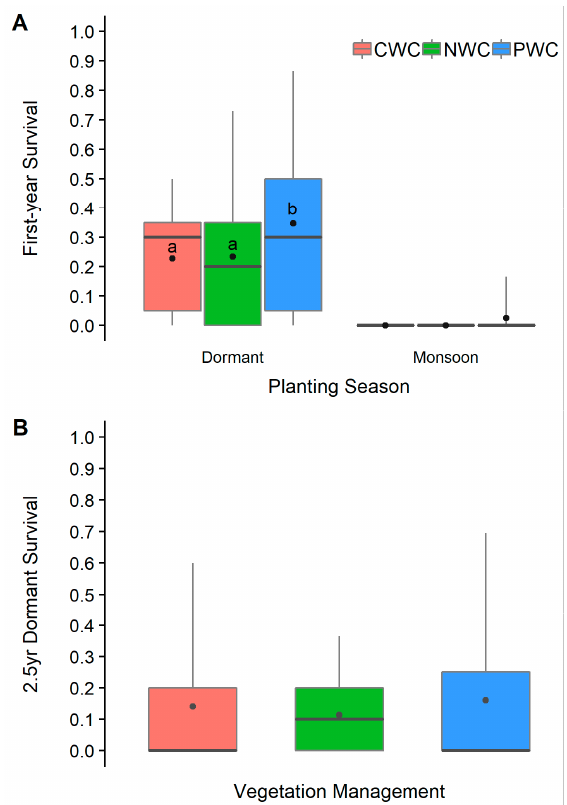
Figure 2. Survival rates of planted ponderosa pine seedlings in the Davis Mountains after 1 year for each planting season and vegetation management treatment combination ( A ) and 2.5 years for dormant season ( B ). Boxplots denote interquartile range, whiskers denote the 2.5th and 97.5th percentiles, grey horizontal line denotes the median, and black points denote the mean for each treatment. Treatments that share letters were not statistically different. Table 3. Overview of fixed effect parameter statistics and model performance.